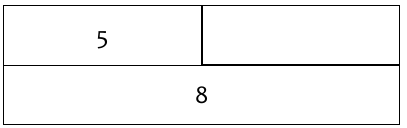
Figure 1: The diagram showing part-whole for eight counters, five removed.